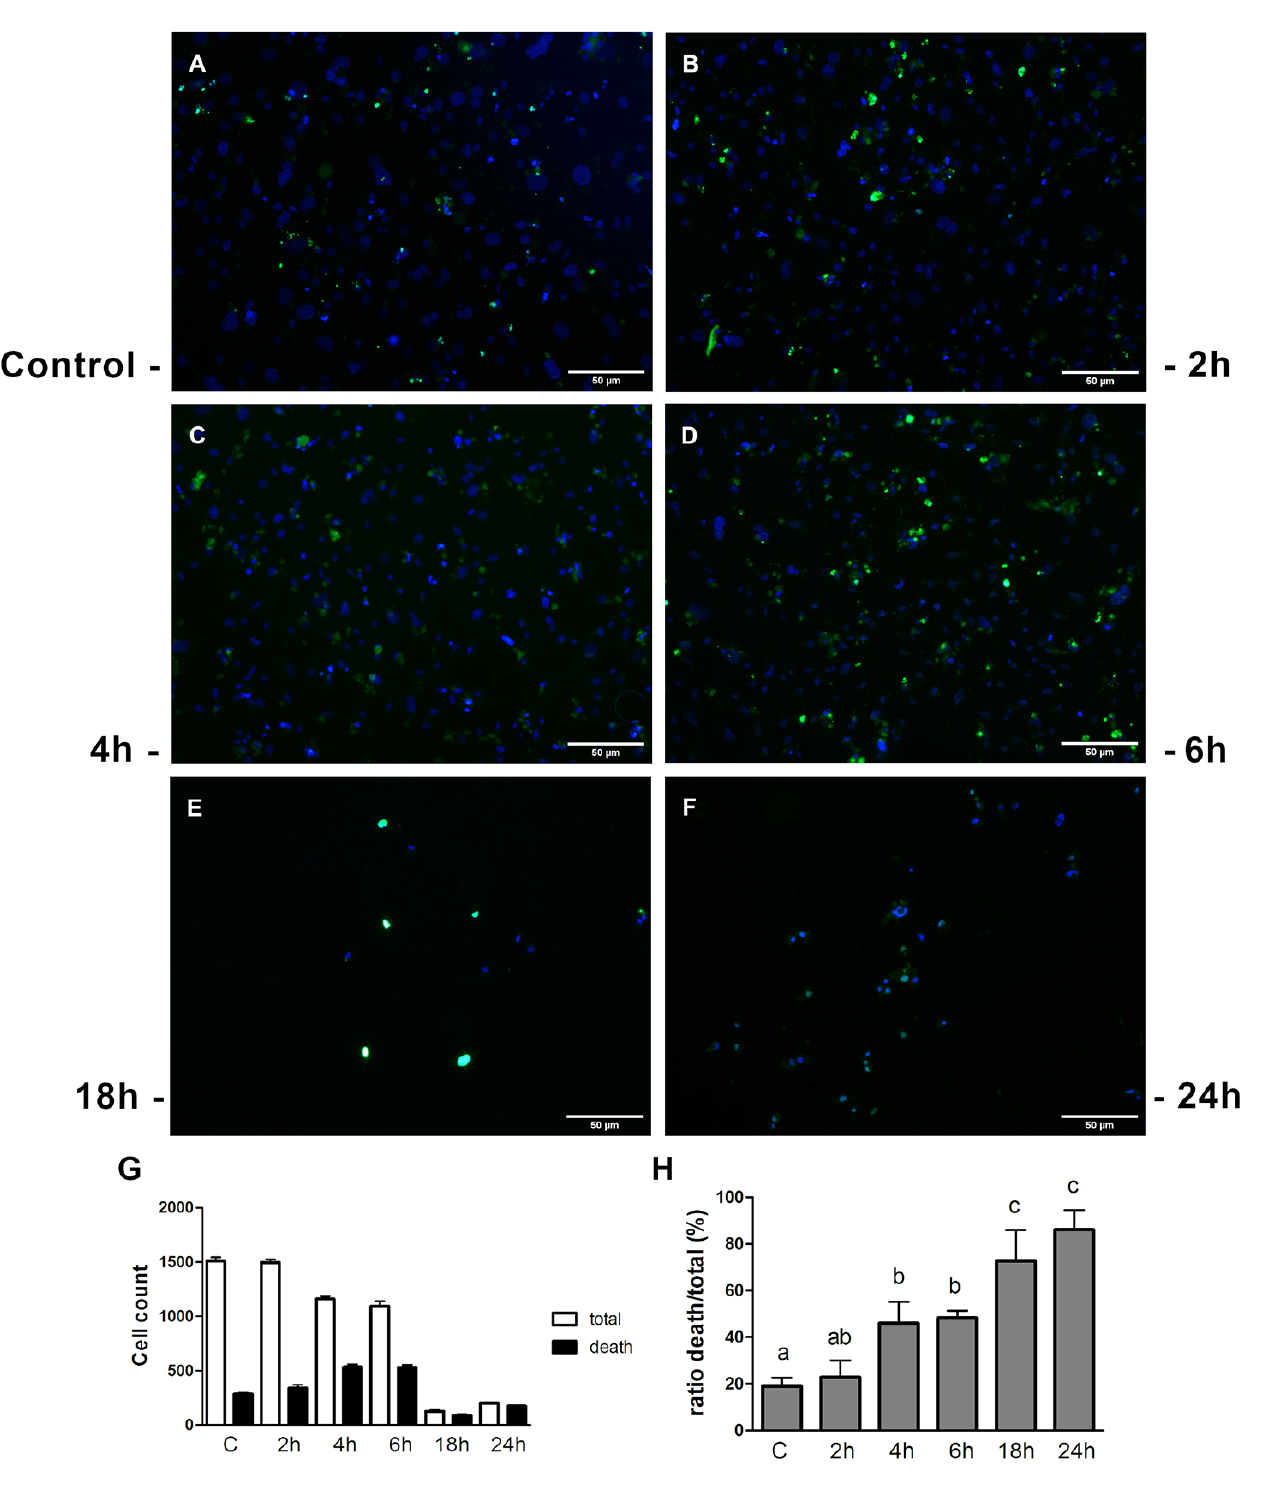
Figure 5. ECVF induces death in avian fibroblasts. (A) CEC-32 control, 24 hours. (B, C, D, E and F) CEC-32 after ECVF exposure, assayed using TUNEL. 2, 4, 6, 18 and 24 hours, respectively. Representative fields of each condition. (G) Total and death cells were counted for each time of ECVF treatment in 5 different fields. Bars represent the sum of these 5 fields. (H) Percentage of the ratio between death/total cells (a, b and c represent statistical different groups). ANOVA one-way, followed by Tukey’s